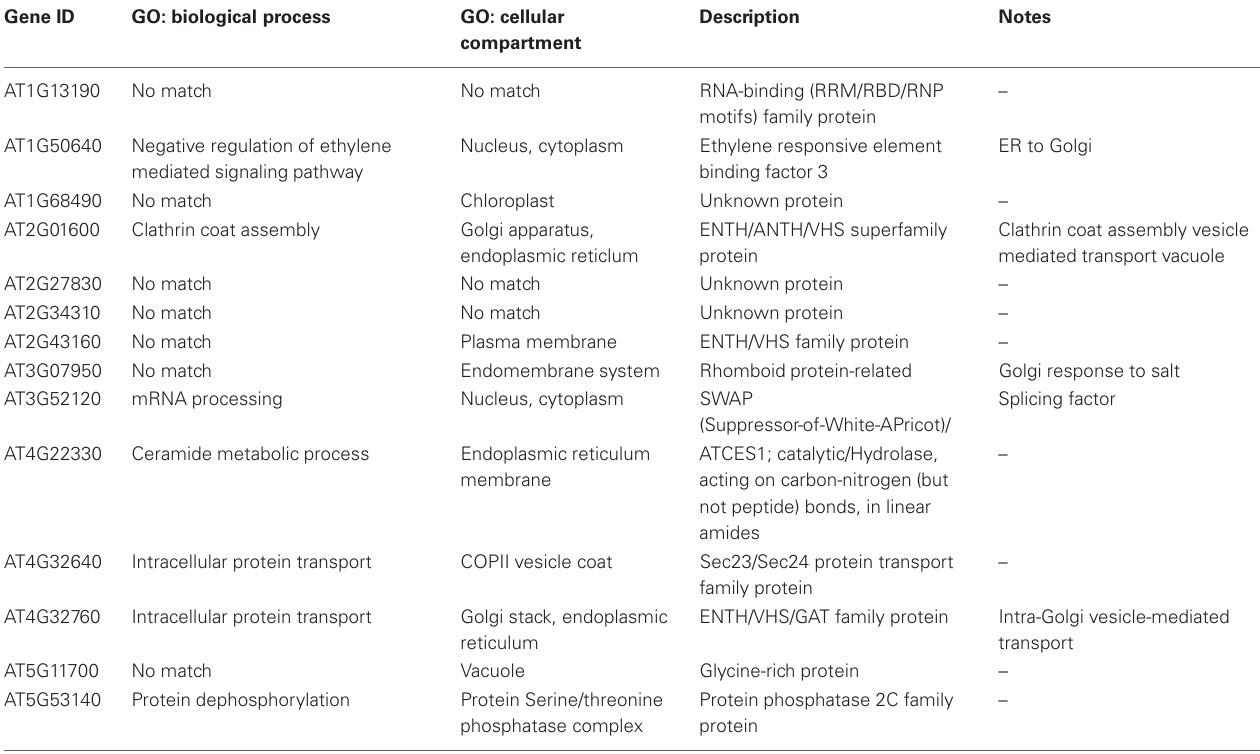
Table 5 | Alpine gene association network